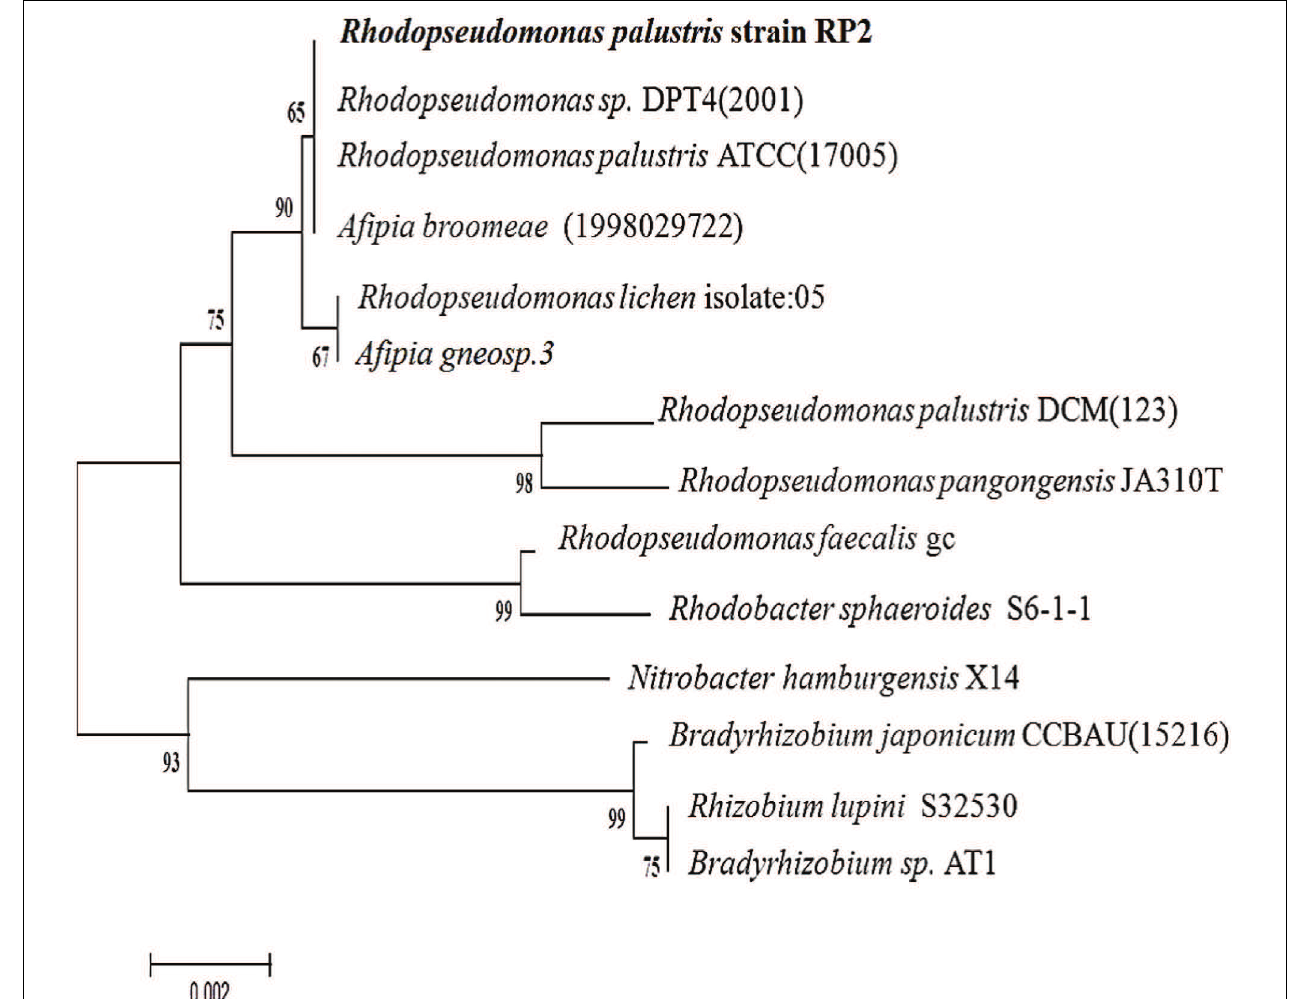
FIGURE 2 | Phylogenetic tree based on 16S rRNA sequences showing the positions of the isolate, R. palustris strain RP2 and representatives of other closely related species. The tree was constructed form 1,420 aligned bases; Scale bar represents 0.002 substitution per